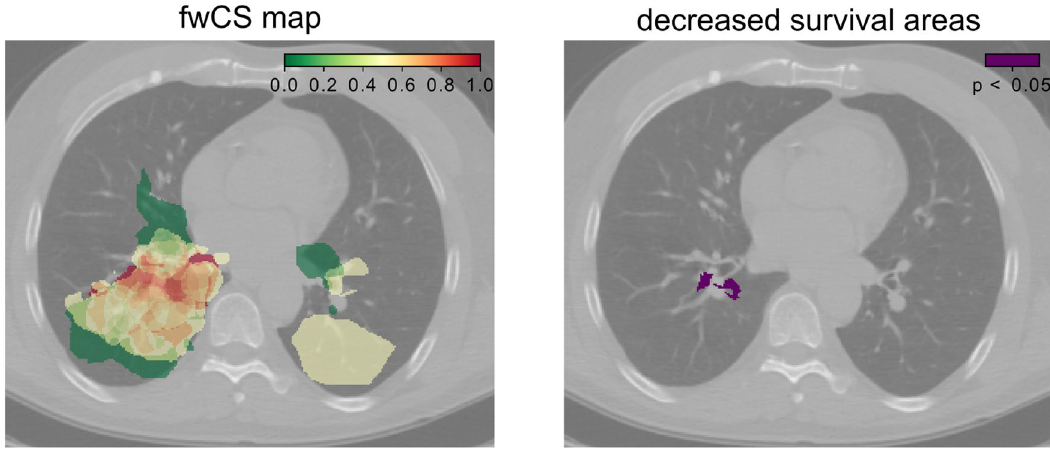
Figure 3. Axial CT slice of S1 frequency weighted cumulative status (fwCS) map on the left and decreased survival areas (DSA) labeled using the permutation method. Violet areas indicate statistically significant regions. Significant areas were found in the right lung close to the